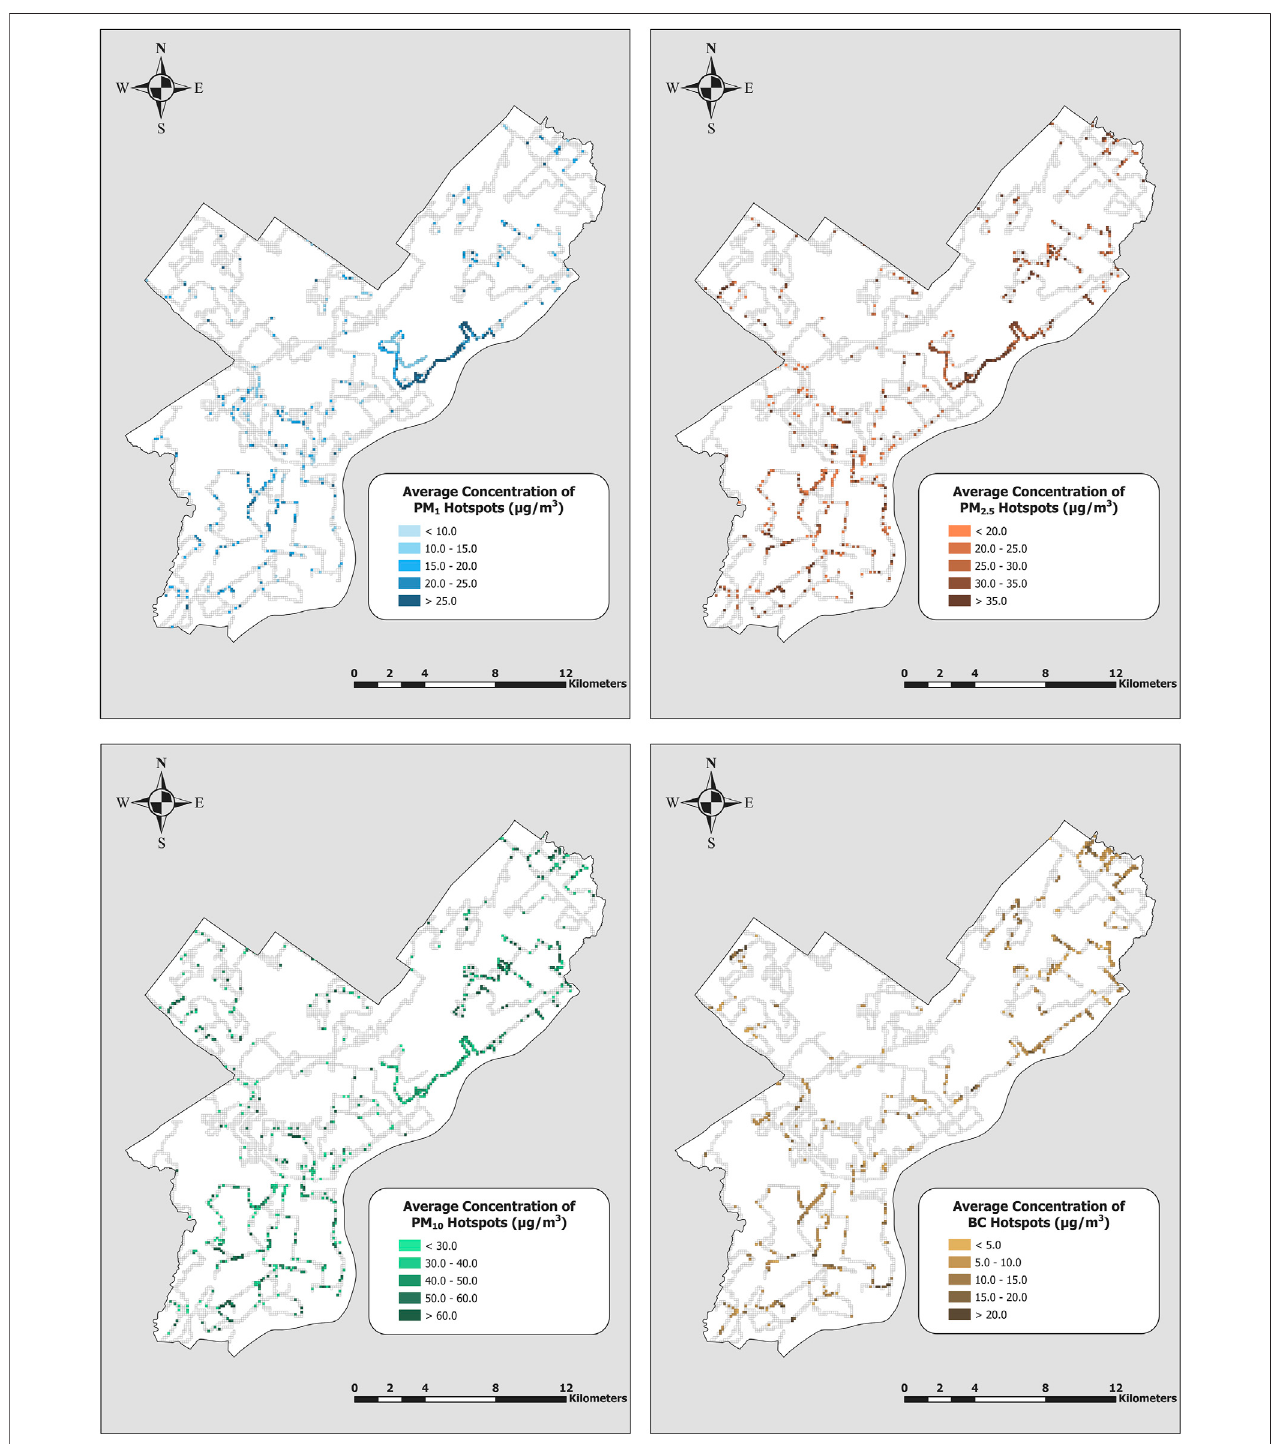
FIGURE6| Mapsdisplayingthelocations andaverageconcentrationsofhotspots forPM 1 (top-left), PM 2.5 (top-right),PM 10 (bottom-left),and BC(bottom-right)in Philadelphia within each 120 m 2 cell sampled. Empty cells indicate that no hotspots were detected at that location.